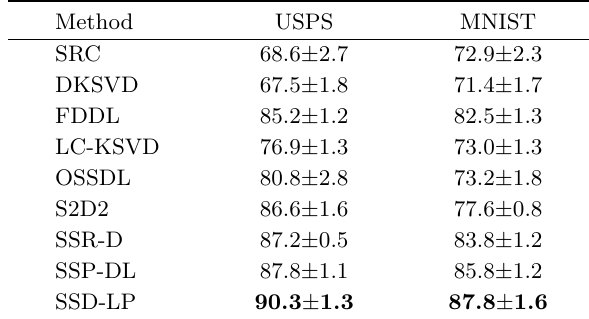
Table 2 Recognition rate for various methods, for different number of labeled training samples, for the Extended YaleB database